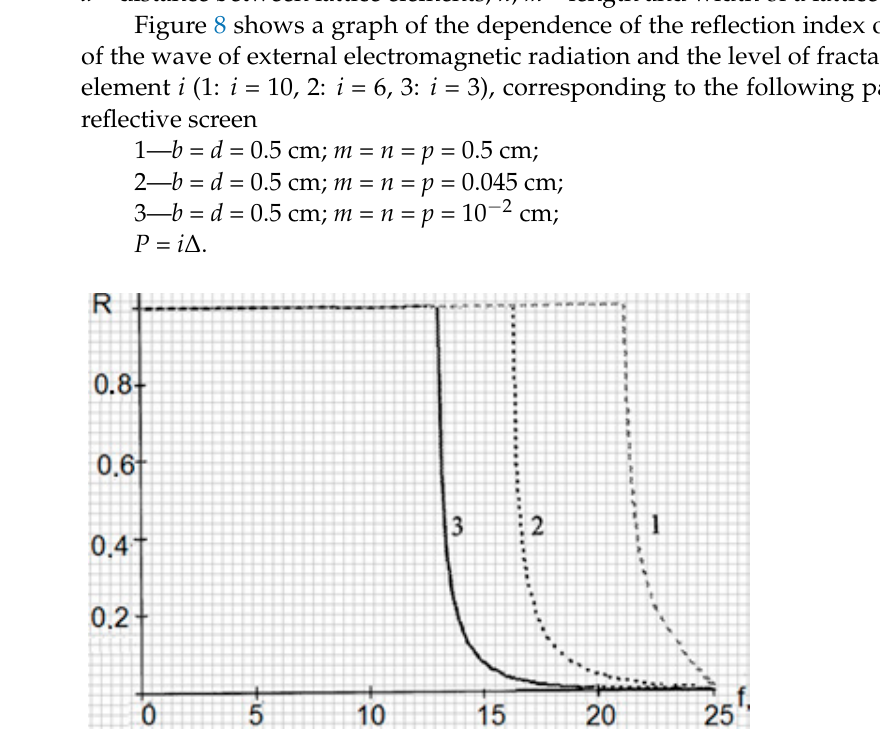
Figure 8. The graph of the dependence of the reflection index on the frequency of external electromagnetic radiation and the level of fractality of the lattice element.